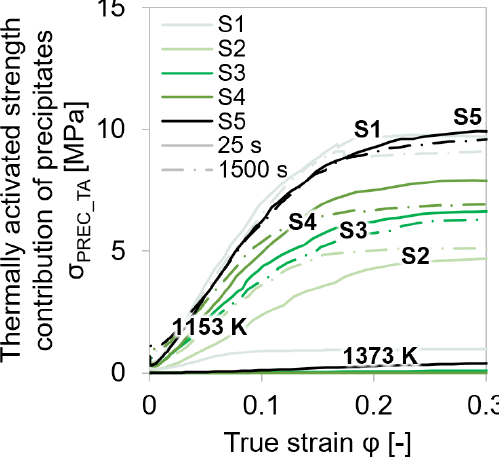
Figure 15. Comparison of thermally activated strength contribution from precipitates at varied tem- peratures and holding times before single-hit deformation for steel grades S1–S5. temperatures and holding times before single-hit deformation for steel grades